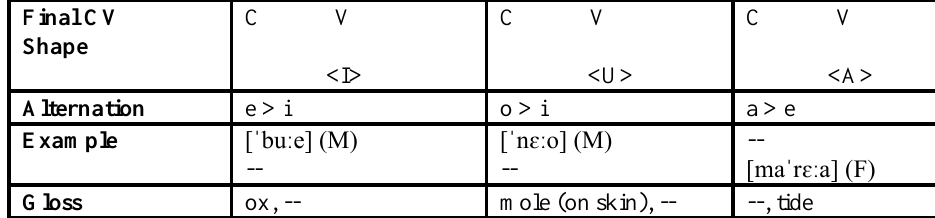
Table 2. C empty, V associated with floating |I|, |U|, or